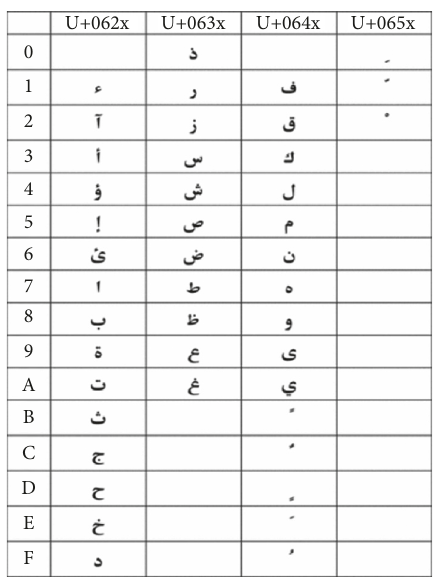
Figure 1: Basic Arabic (Unicode block): 28 letters and 8 diacritics.